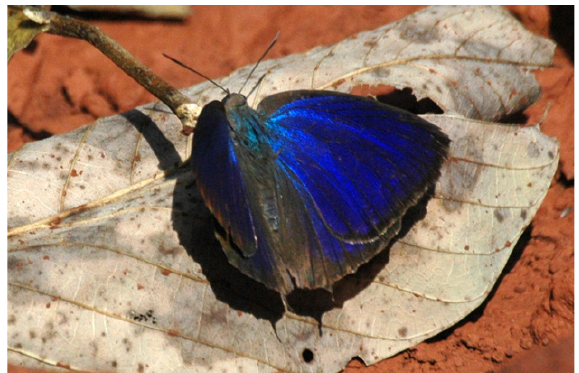
Image 6. Blue Mormon Papilio polymnestor